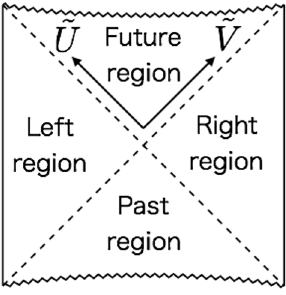
Figure 2 . Penrose diagram of the Rindler-AdS black hole space time with an appropriate transfor- mation ˜ U ( U ) and ˜ V ( V ) . The space time is divided into four regions by the horizons at ˜ U = U = 0 and ˜ V = V = 0